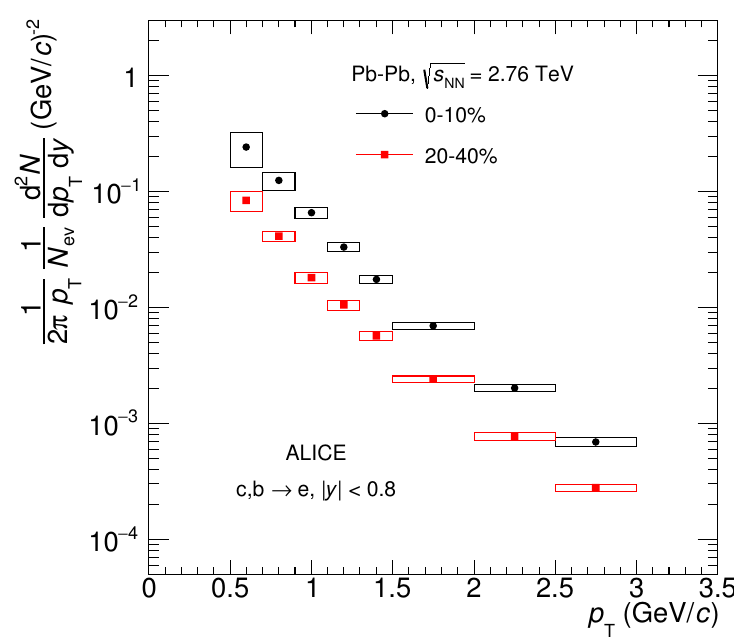
Figure 2 . The p T -di(cid:11)erential invariant yields of electrons from semileptonic heavy-(cid:13)avour hadron decays measured at mid-rapidity in 0{10% and 20{40% central Pb{Pb collisions at 2 : 76 TeV. Statistical uncertainties are smaller than the symbol size and the systematic uncertainties are shown as